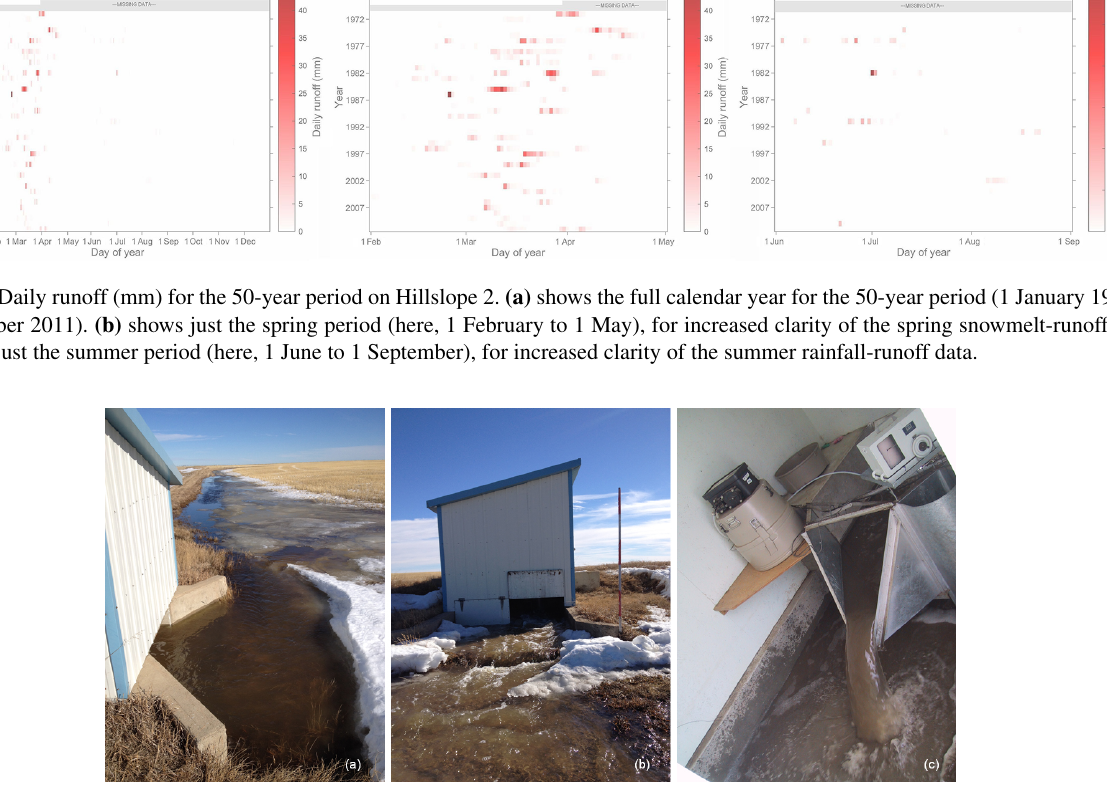
Figure 3. Photographs of the runoff shed at Hillslope 2. (a) Facing east, at the inflow side of the shed (taken March 2014). (b) Facing south, at the outflow side of the shed (taken March 2014). (c) Inside the shed, showing a 0.61m H flume, a Stevens water level chart recorder, and an automated ISCO 3700 Portable